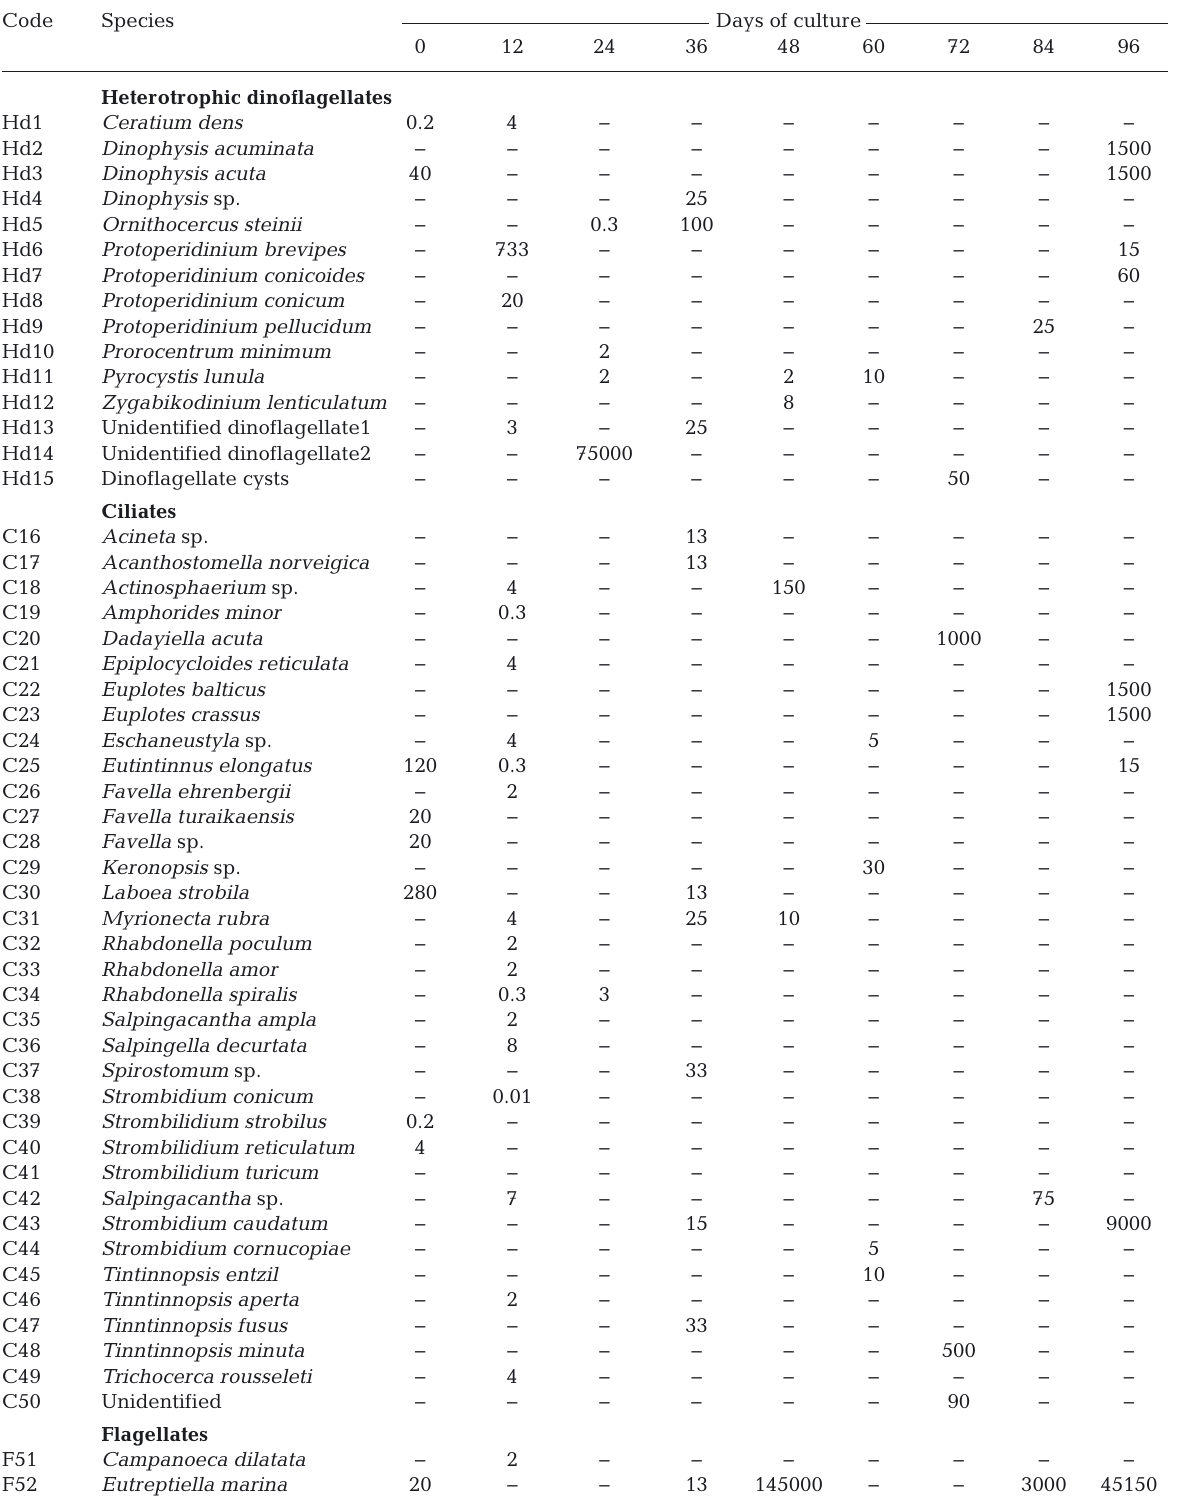
Table 3. Temporal variation in abundance (ind. l −1 ) of microzooplankton communities during the culture of